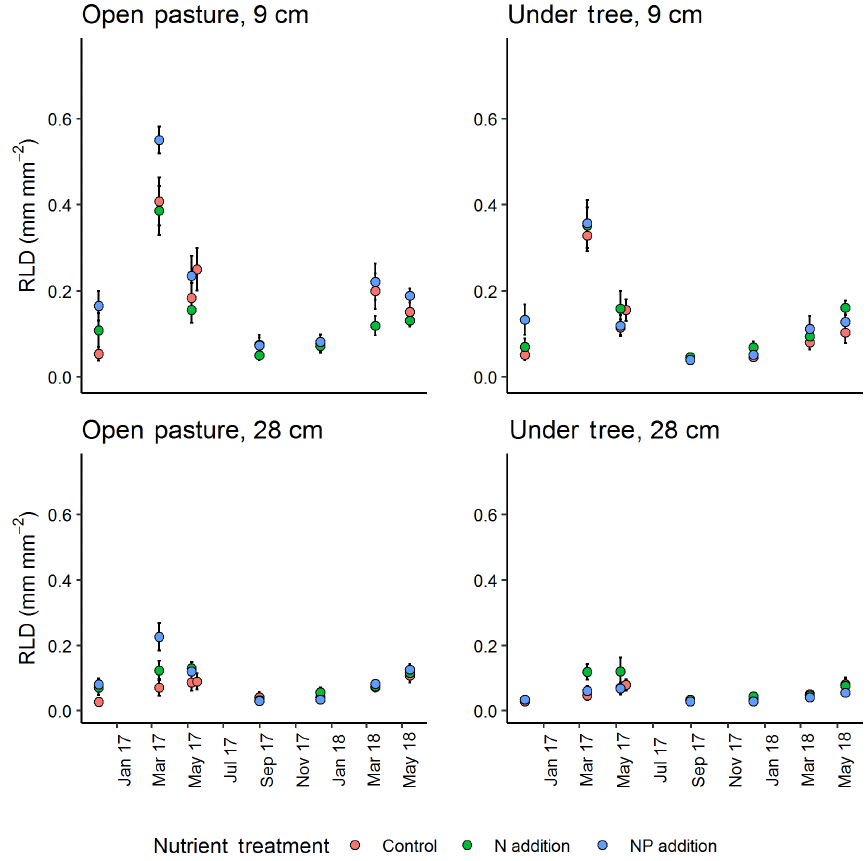
Figure 4. Seasonal cycle of minirhizotron-calculated root length density (RLD) between treatment at two selected depths (vertical position of camera). +NP treatments tended to diverge, especially in spring 2017. Error bars show value ± SE. A mixed-effect model revealed a significant effect of the +NP treatment ( P < 0 . 005) but N did not differ from